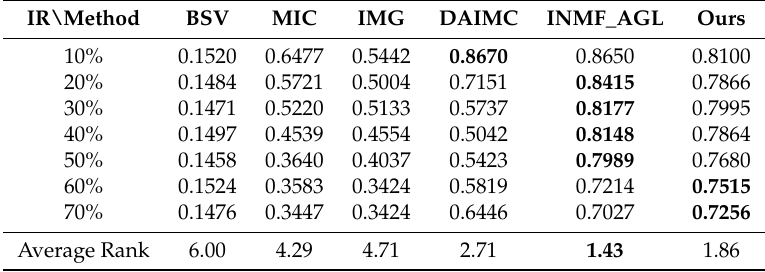
Table 5. ACCs and average ranks on Mfeat under different incomplete ratios. Bold numbers denote the best